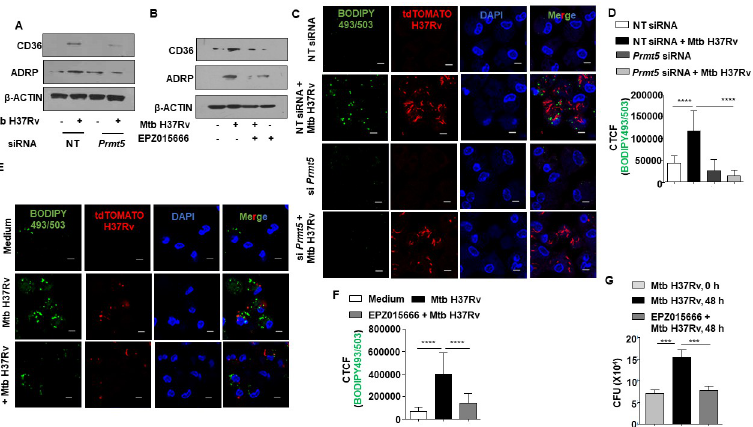
Fig 5. PRMT5 activity aids in the sustained accumulation of lipid droplets during Mtb infection. (A) Mouse peritoneal macrophages were transfected with NT or Prmt5 siRNAs. Transfected cells were infected with Mtb H37Rv for 24 h and assessed for the expression of ADRP and CD36 by immunoblotting. (B) Mouse peritoneal macrophages were treated with PRMT5 inhibitor EPZ015666 for 1 h, followed by 24 h infection with Mtb H37Rv. Whole cell lysates were assessed for the expression of ADRP and CD36 by immunoblotting. (C, D) Mouse peritoneal macrophages were transfected with NT or Prmt5 siRNAs. Transfected cells were infected with tdTomato Mtb H37Rv for 48 h and analyzed for lipid accumulation (BODIPY493/503) by confocal microscopy; (C) representative image and (D) respective quantification. (E, F) Mouse peritoneal macrophages were treated with PRMT5 inhibitor EPZ015666 for 1 h, followed by 48 h infection with tdTomato Mtb H37Rv and analyzed for lipid accumulation (BODIPY493/503) by confocal microscopy; (E) representative image and (F) respective quantification. (G) Mouse peritoneal macrophages were infected with Mtb H37Rv for 4 h. Extracellular bacteria were removed, and the infected cells were cultured in the presence or absence of PRMT5 inhibitor EPZ015666 for 48 h. Cells were lysed and plated on 7H11 to enumerate intracellular Mtb H37Rv burden. All immunoblotting and immunofluorescence data are representative of three independent experiments. NT, non-targeting; CTCF, corrected total cell fluorescence; CFU, colony forming units. ��� p < 0.001; ���� , p < 0.0001 (One way ANOVA; GraphPad Prism